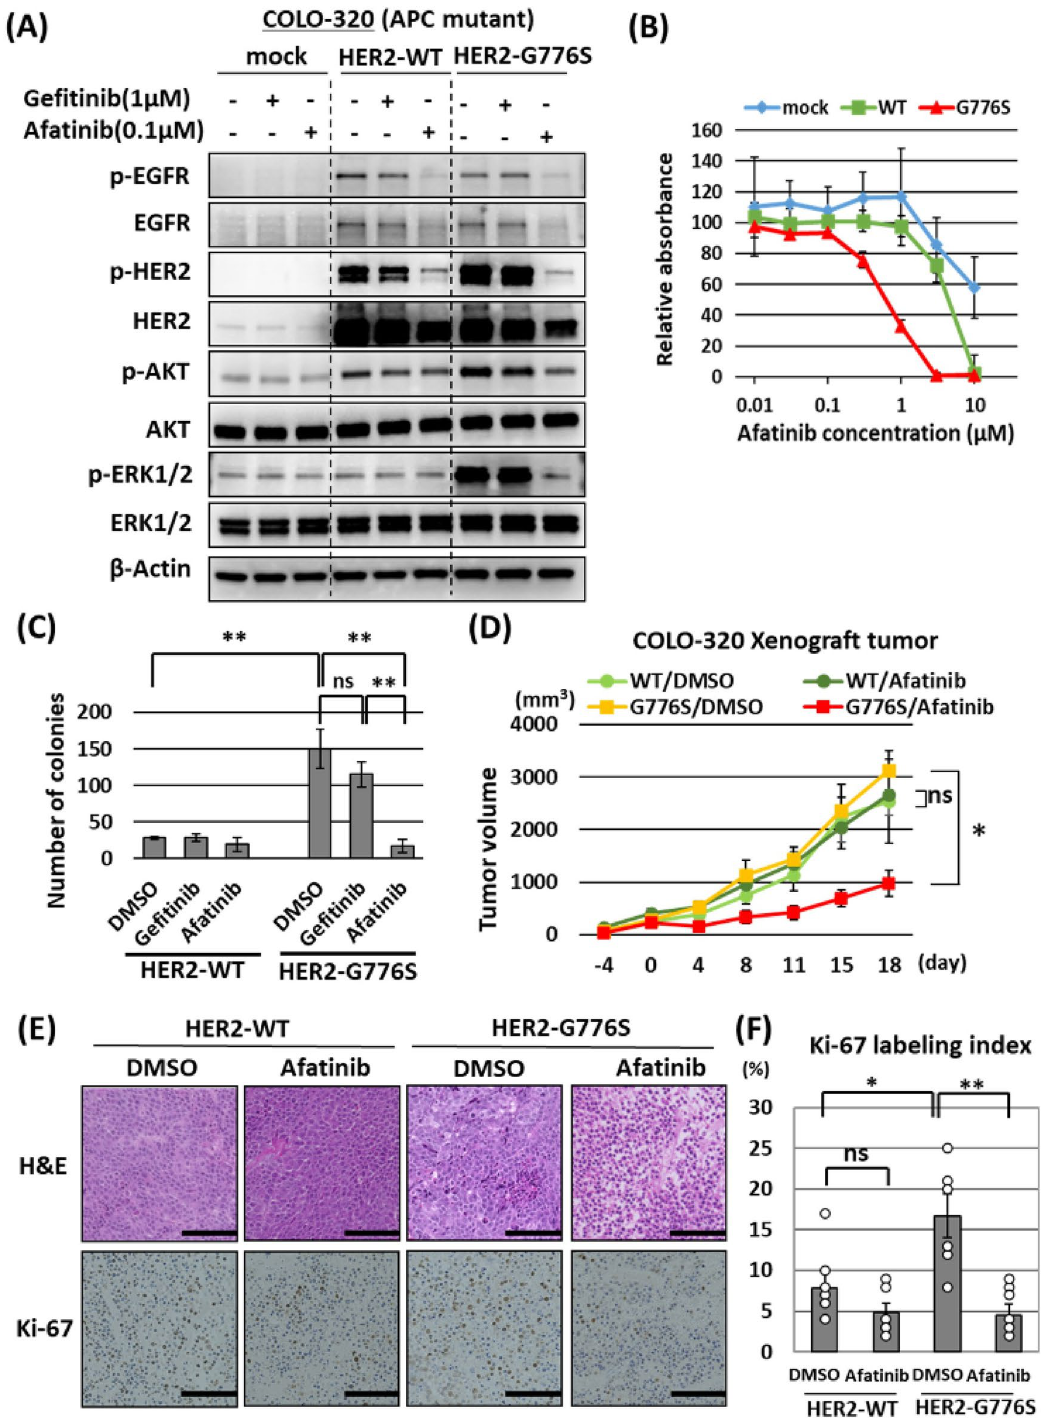
Figure 6. Efficacy of afatinib treatment in COLO-320 cells stably transfected with HER2 G776S. ( A ) Western blot results show the effects of gefitinib (1 μM) or afatinib (0.1 μM) treatment in COLO-320 cells transfected with WT HER2 or HER2 G776S. One day after seeding, the cells were treated for 24 h. ( B ) Cell proliferation assay (WST-1 assay) results show the effects of afatinib treatment in COLO-320 cells transfected with HER2 expression vectors. The cells were exposed to afatinib at the indicated concentrations for 24 h. ( C ) Number of colonies per well in the colony-forming assay treated with DMSO, gefitinib (1 μM) or afatinib (0.1 μM). Cells were seeded into six-well plates in triplicate and treated for 10 days. The number of colonies was counted in six random low-power fields. ns, not significant. ** P < 0.01 vs DMSO treatment. ( D ) The efficacy of afatinib treatment in HER2 WT or HER2 G776S stably expressing COLO-320 xenograft tumors. Xenograft tumors were treated with DMSO or afatinib (25 mg/kg/day p.o.). Two-way ANOVA: interaction P < 0.01, ns, not significant. * P < 0.05 ( n = 6). ( E ) Images of hematoxylin and eosin staining of xenograft tumor tissues in each treatment group and images of immunohistochemical staining for Ki-67 on day 18. Scale bar, 100 μm. ( F ) Rates of Ki-67- positively stained cells observed in six random fields. ns, not significant. Two-way ANOVA: interaction P < 0.01, * P < 0.05, ** P <